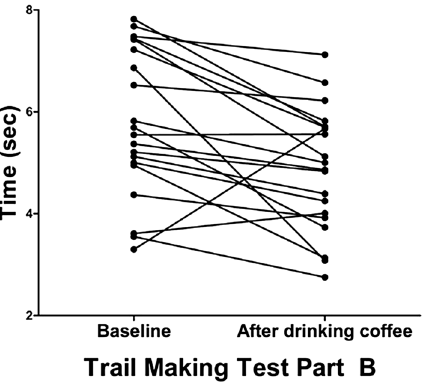
Figure 2. Acute effects of coffee consumption on executive function. Individual changes in time (s) to complete Trail Making Test Part B are